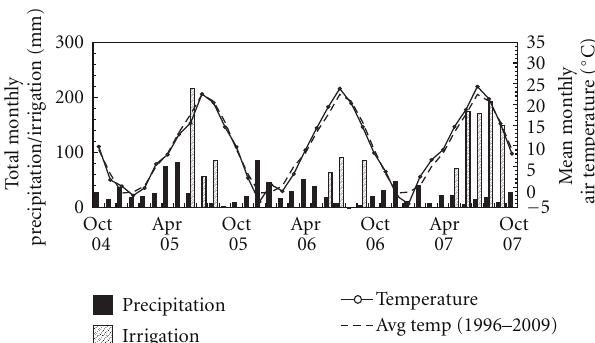
Figure 1: Total monthly precipitation and irrigation amounts, and mean monthly air temperature at the study site from fall 2004, when the first manure treatment was applied, through the 2007 growing season, when sugarbeet was planted on the experimental